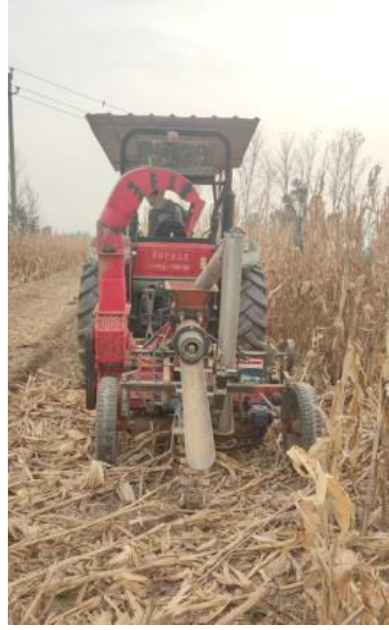
Figure 8. The machine field operation test.